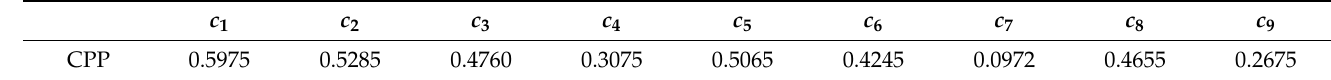
Table 3. Comprehensive posterior probability of characteristic quantities c 1–9 .